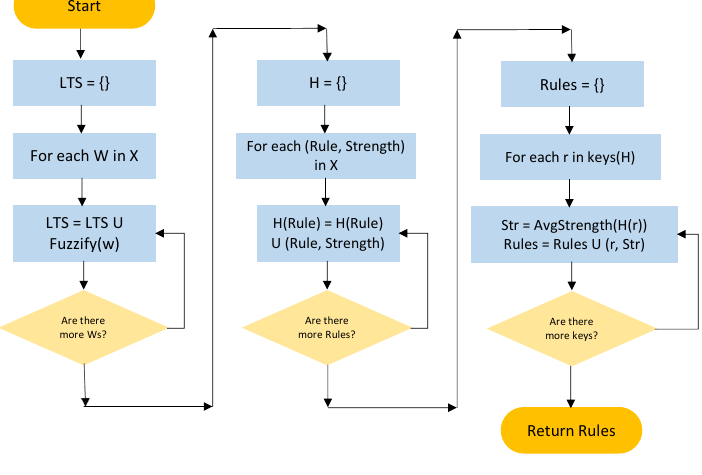
Figure 3. LearnRules ( X , m , τ ) .